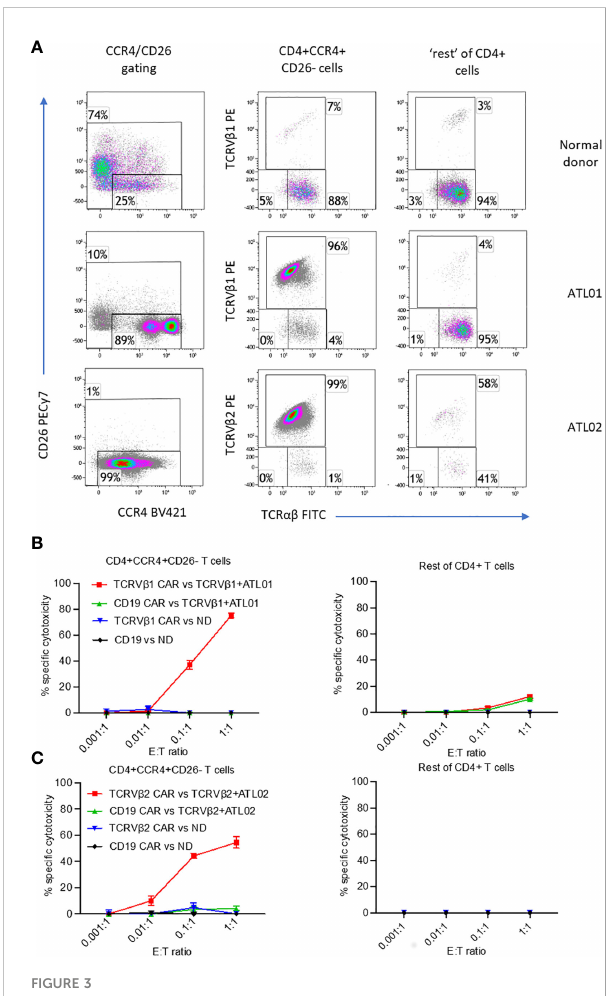
FIGURE 3 Killing of ex vivo CD4+CCR4+CD26- ATL cells expressing TCRV b 1 and V b 2 by anti-TCRV b CAR-iNKT. Cryopreserved PBMC from two ATL patients and normal donor (ND) were stained with CellTrace violet and co-incubated with anti-V b 1 -V b 2 or-CD19 CAR-iNKT at the indicated effector:target (PBMC) ratios in triplicate. (A) Immunophenotype of samples before co-culture. After 24h co- culture, cells were stained with a viability stain, anti-CD4, CCR4, CD26, TCRV b 1 or 2 and TCR ab , fi xed, and the frequency of dead CD4+CCR4+CD26- T cells and CCR4- and CCR4+CD26+ cells ( ‘ rest ’ of CD4+ T cells) was determined by fl ow cytometry. (B) Killing of cells from patient ATL01 and the normal donor by TCRVbeta1 CAR-iNKT. (C) Killing of cells from patient ATL02 and the normal donor by TCRVbeta2